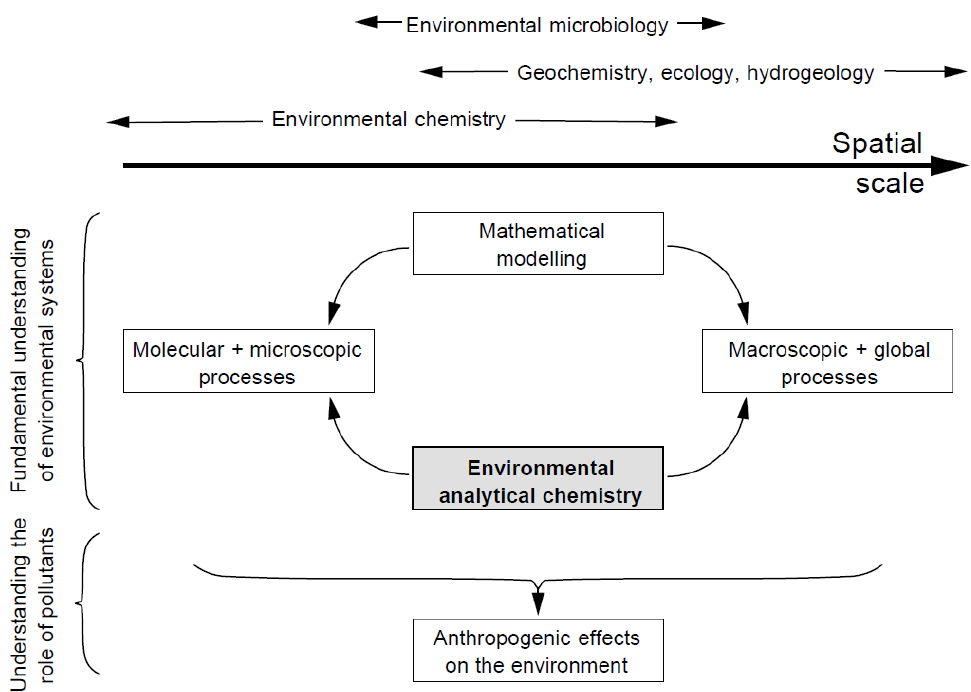
Figure 1. Situation of analytical chemistry in the context of environmental chemistry. Analytical chemistry links the macroscopic and global processes with those occurring at the molecular and microscopic level under both undisturbed systems and those subject to contamination systems. Adapted from [1] with